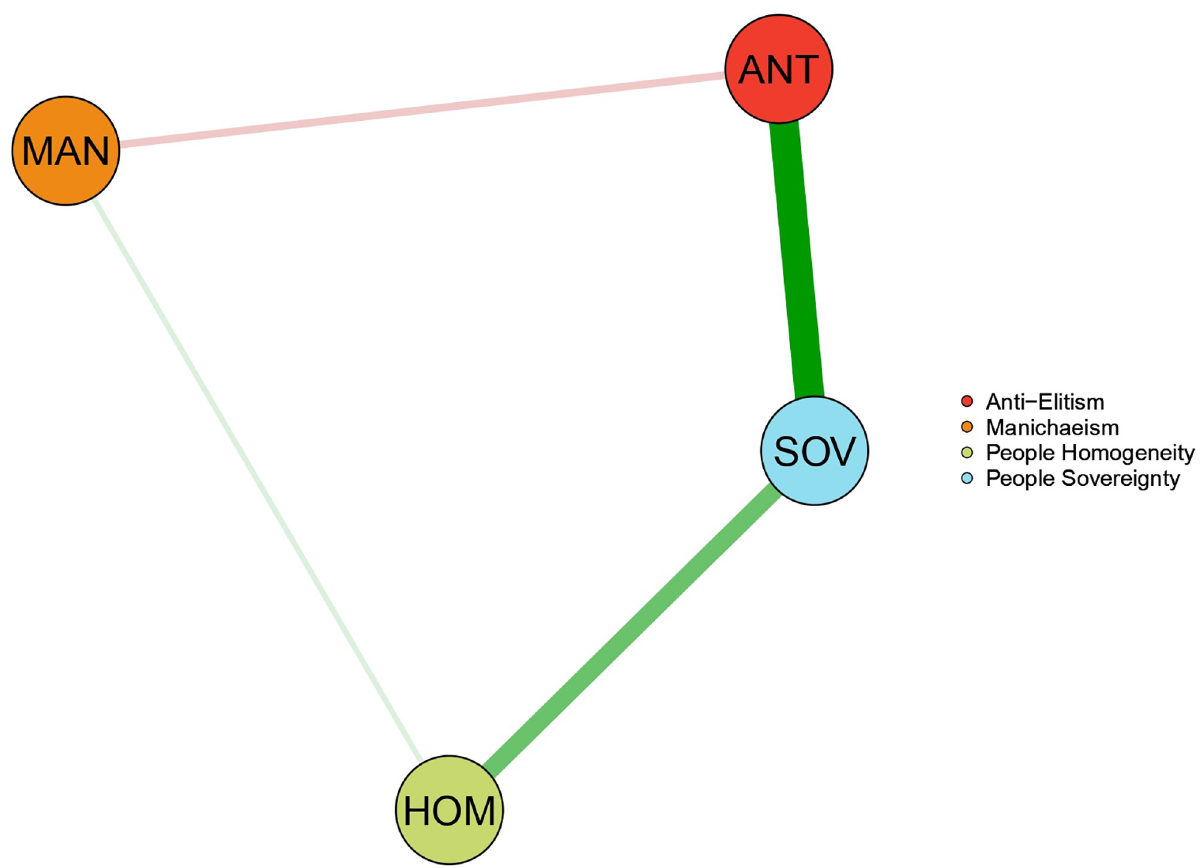
Fig 3. Network of populist ideology dimensions. It reports the network model investigating populist narratives’ centrality.